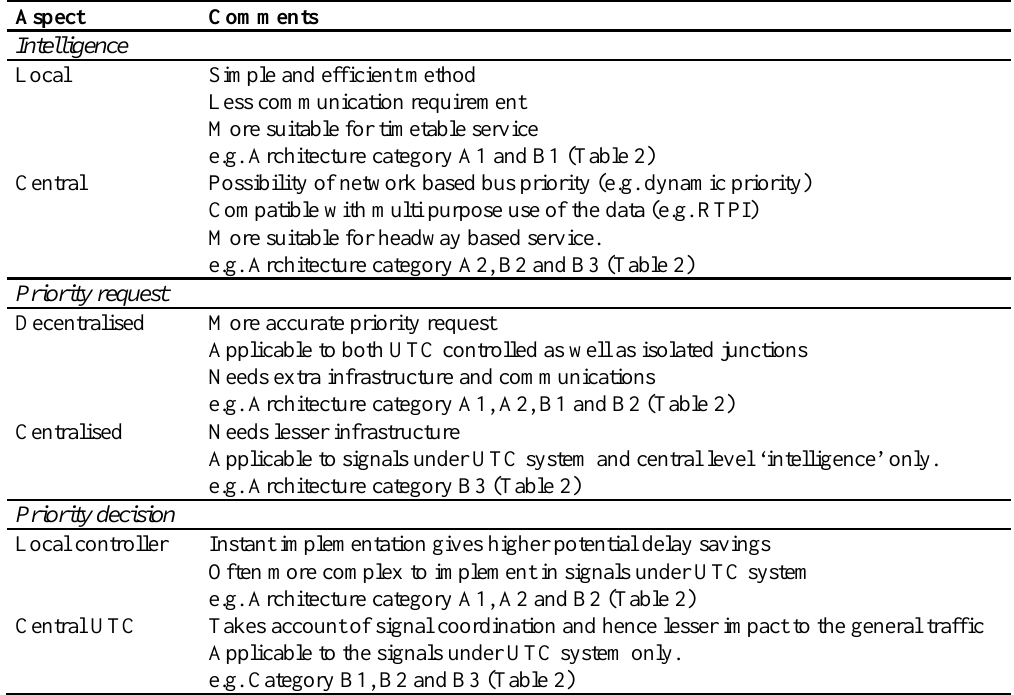
Table 1. Options available within different aspects of bus priority